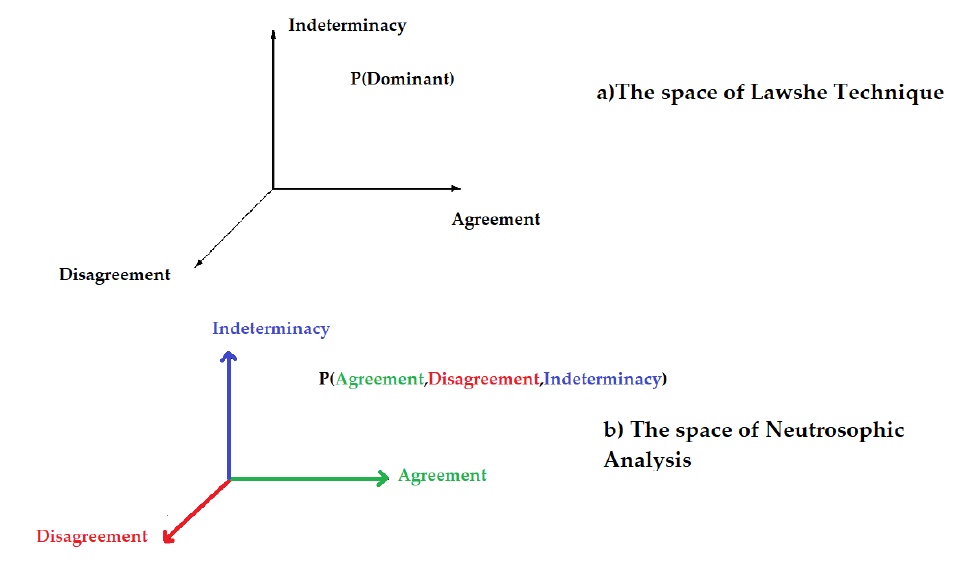
Fig. 6. The difference between the space and parameters of the Lawshe technique with neutrosophic